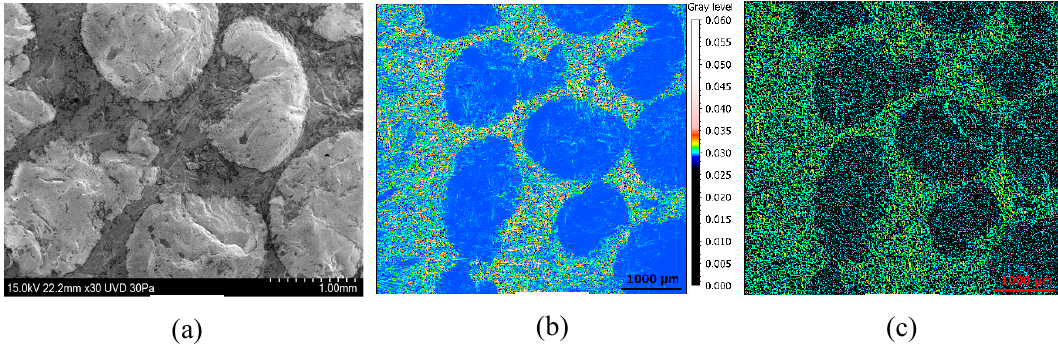
Figure 13. SEM image ( a ), Mehlum curvature map ( b ), and furrows map ( c ) of a measurement of the surface 4.